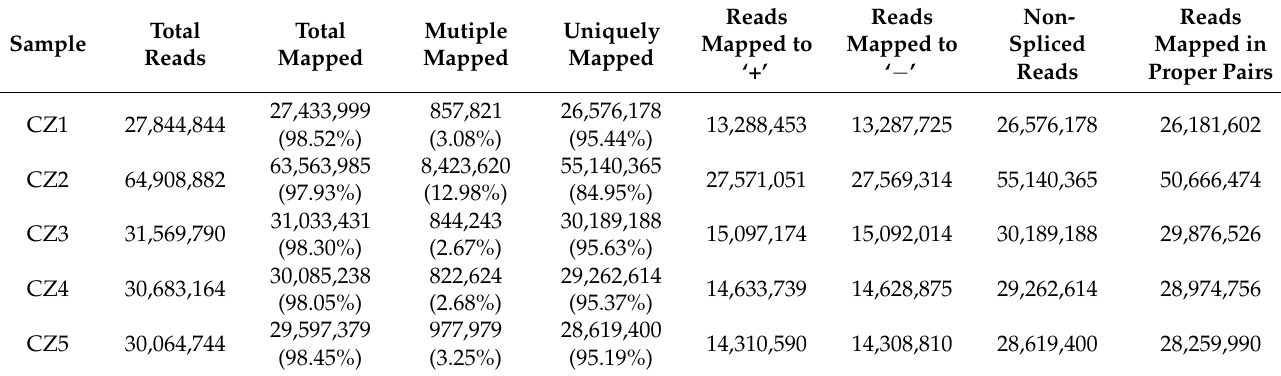
Table 2. Reference genome comparison